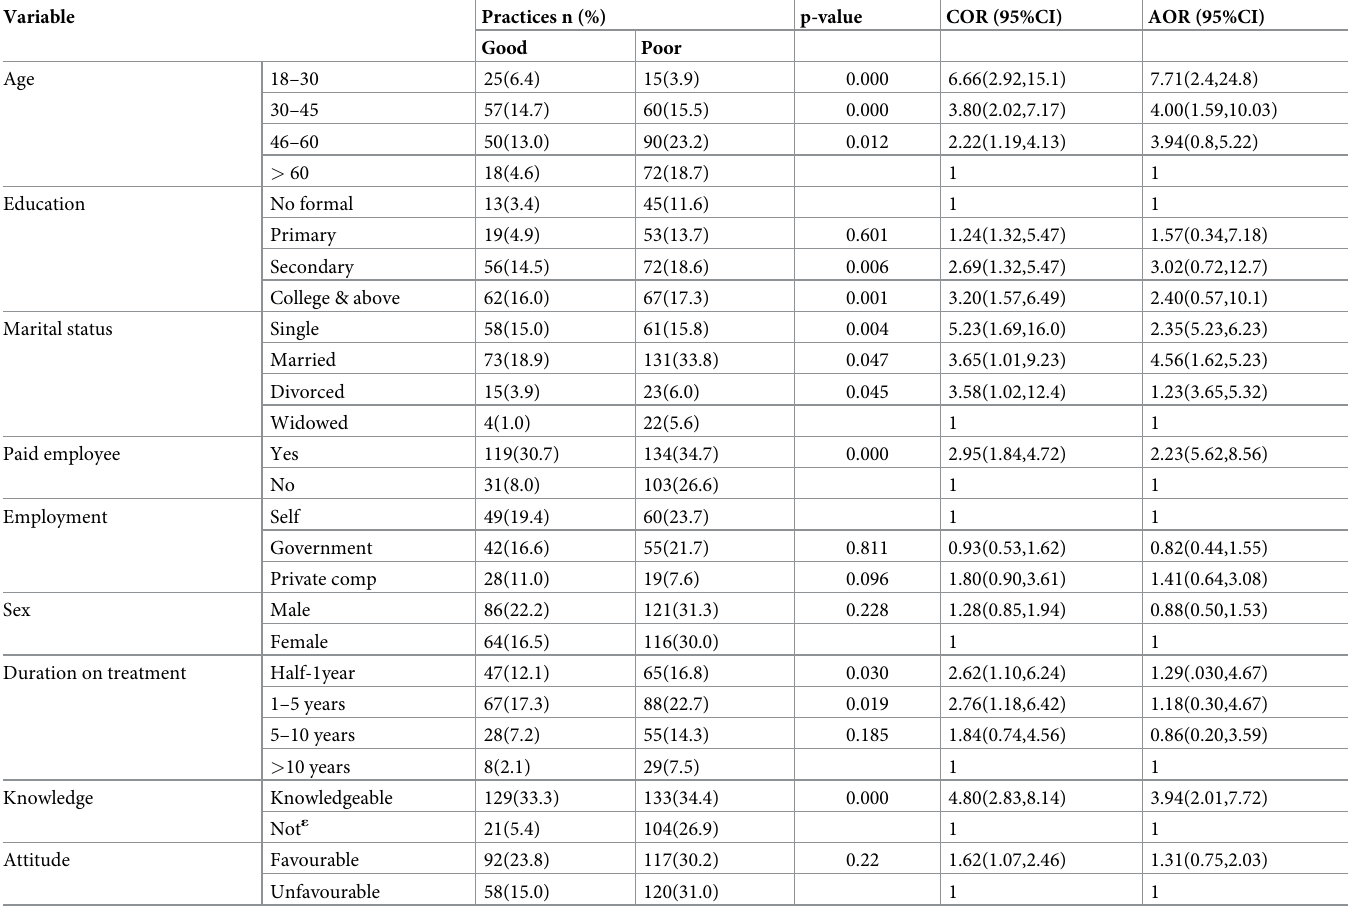
Table 9. Factors independently associated with practices of hypertensive patients on treatment follow up regarding lifestyle modification at Yekatit 12 General hos- pital in 2019 (n = 387).